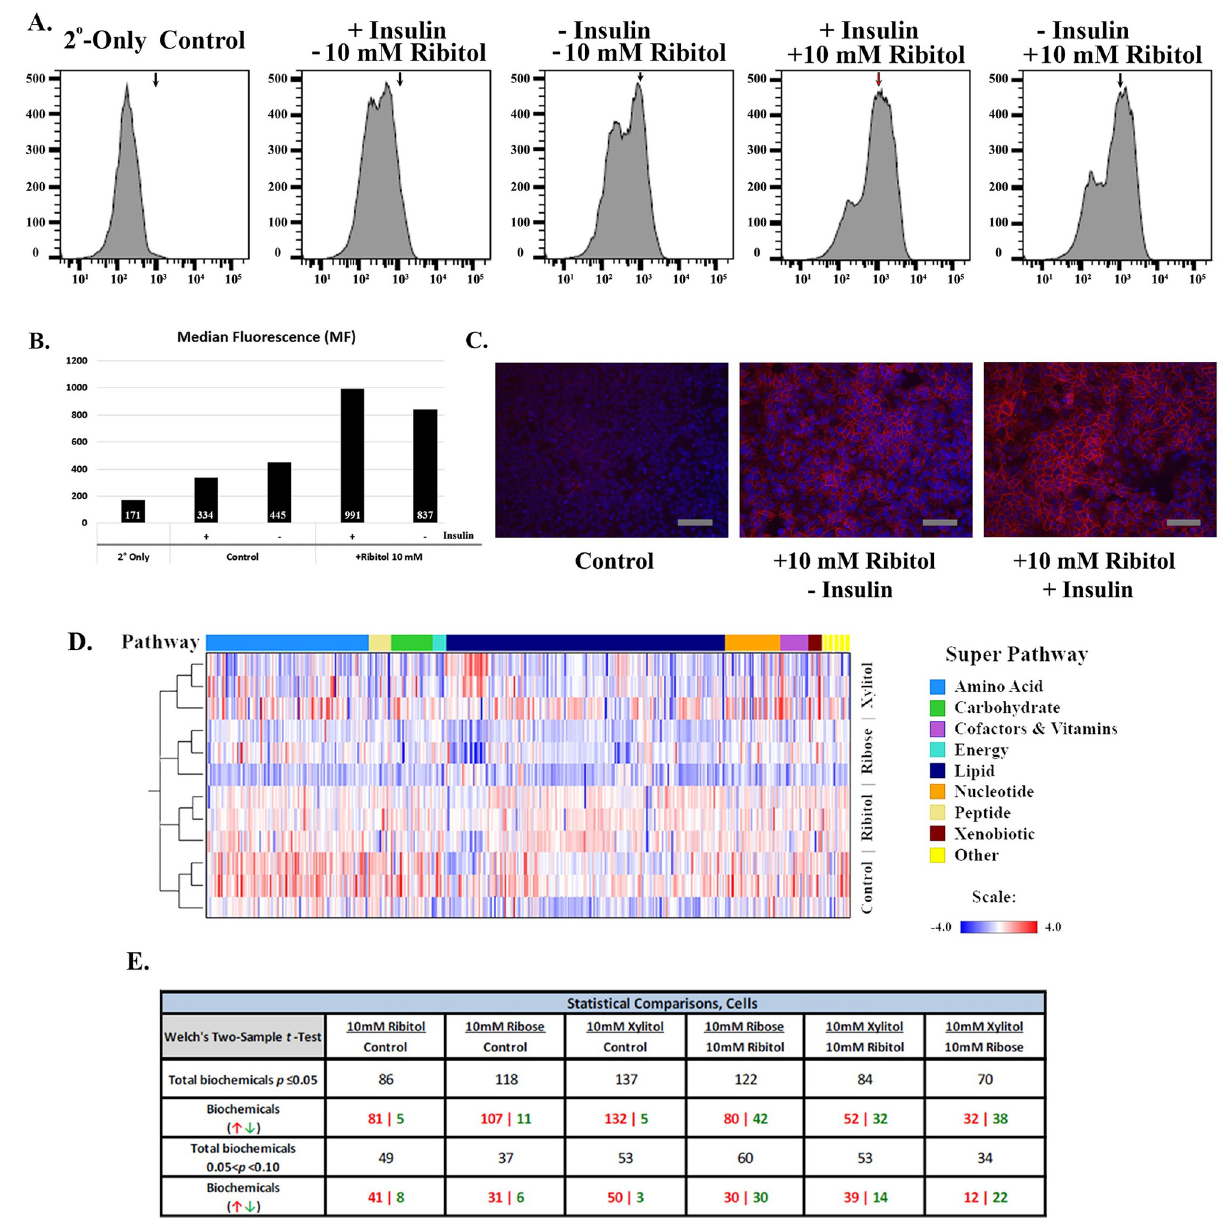
Fig 1. Matriglycan expression in MCF-7 cells treated with ribitol. MCF-7 breast cancer cells were incubated for 72 hours with ribitol (10 mM) supplementation, with and without insulin in the base media, and analyzed by flow cytometry for detection of glycosylated α -dystroglycan (A) Representative histograms demonstrating the distribution and median X axis, fluorescence intensity; Y axis, number of cells. Red arrow indicates peak of highest MF, and black arrow indicate corresponding position in each histogram. (B) Mean fluorescence intensity of MCF7 cells after ribitol treatment. (C) Representative micrographs of IIH6 ICC staining for glycosylated matriglycan in untreated control and 10 mM ribitol supplementation with and without insulin in culture media. 2 nd Ab-only control denotes staining with secondary antibody only, scale bar represents 200 μ m. Metabolomic analysis of MCF7 cell lysates. (D) Hierarchical clustering analysis (HCA) heatmap of global metabolic profile alterations by pathway, amongst MCF-7 cells treated with 10 mM ribitol, 10 mM ribose, and 10 mM xylitol. (E) Comparison of statistically significant biochemical changes amongst metabolomic profiles of MCF-7 cells treated with ribitol, ribose, and xylitol. Cellular lysates compared by treatment to control, and between treatment groups. The two conditions compared make up the first row, with the total number of biochemicals reaching significance by two-sample t- Test p � 0.05 depicted in the second row, delineated by those increased or decreased in the third row. The count of biochemicals approaching significance, with two-sample t-Test 0.05 < p < 0.10 are depicted in the fourth row, and their change as increase or decrease separated in the fifth row.